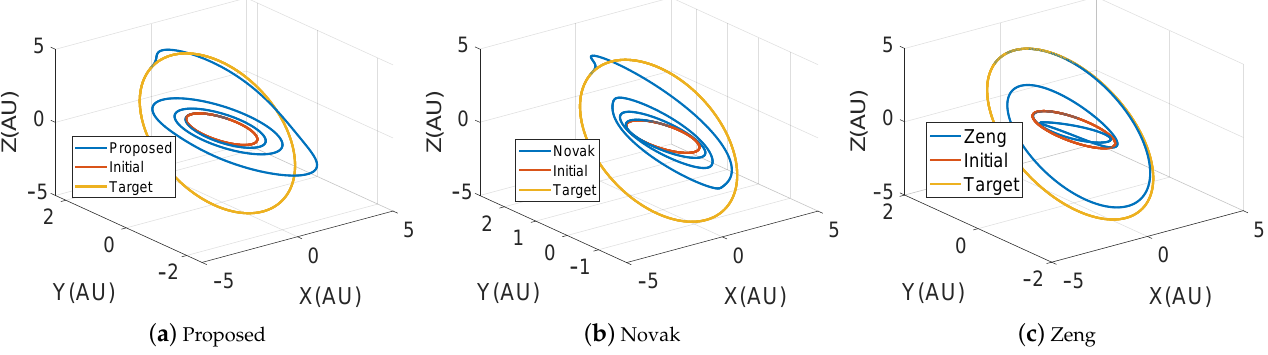
Figure 4. Rendezvous results of three methods when r 1 < r 2 .